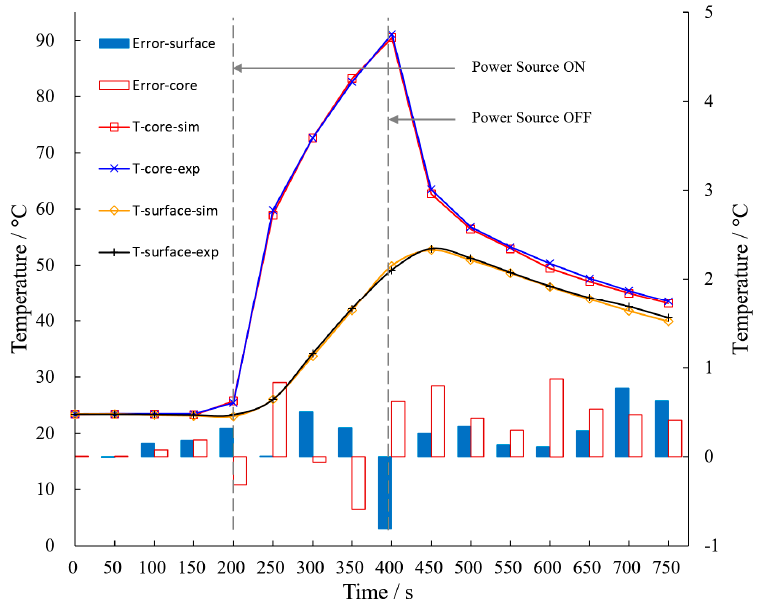
Figure 6. Comparison of temperatures from simulation and experiment.